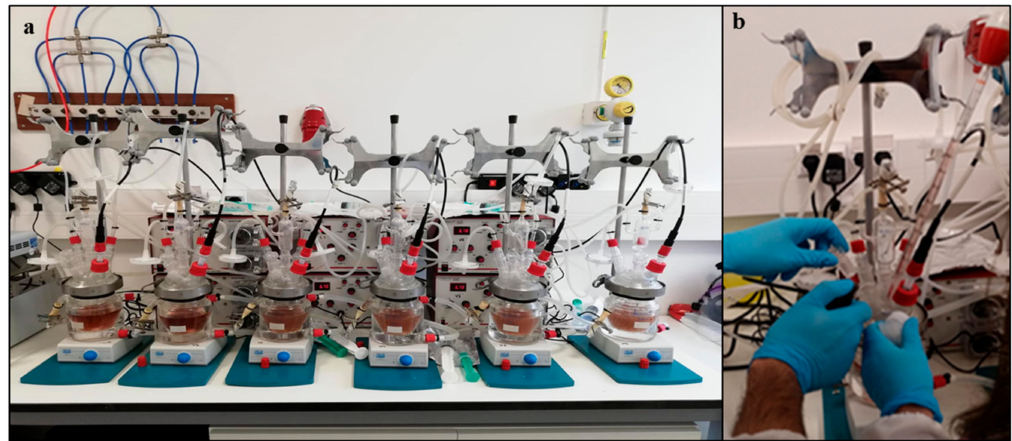
Figure 2. ( a ) In vitro Batch-Culture Fermentations Models, ( b ) Sampling Procedure. Table 3. Gut Bacteria Enumeration Platting Conditions of the Fresh Individual (D1–D5) and P Fresh ( 1 ) Inoculums and Conditions I–IV, and Inoculums A and B ( 2